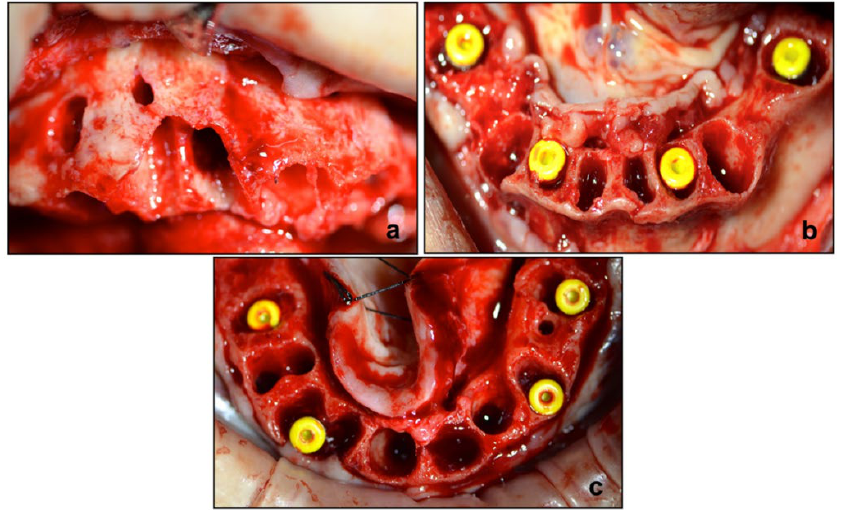
Figure 4. Intraoperative procedure. ( a ) Site preparation for Guided Bone Regeneration procedure and Max Stability implants positioned in the upper ( b ) and lower ( c ) jaw.